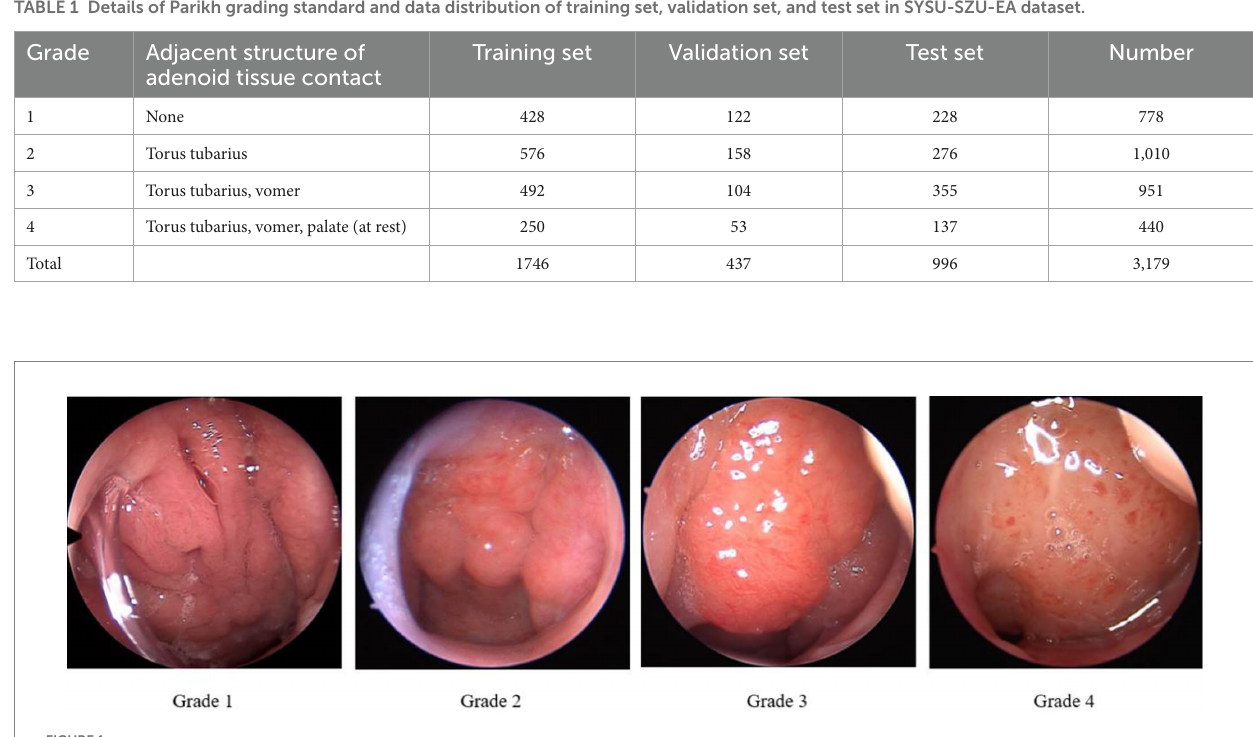
FIGURE 1 Examples of 4 grades adenoid nasoendoscopic images according to Parikh grading standard in the SYSU-SZU-EA